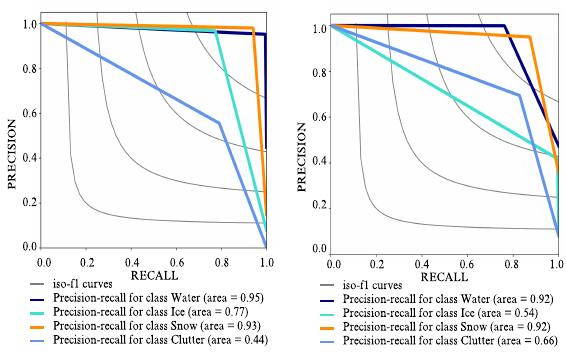
Figure 8: Precision-recall curves (Lake St. Moritz). Best if viewed on